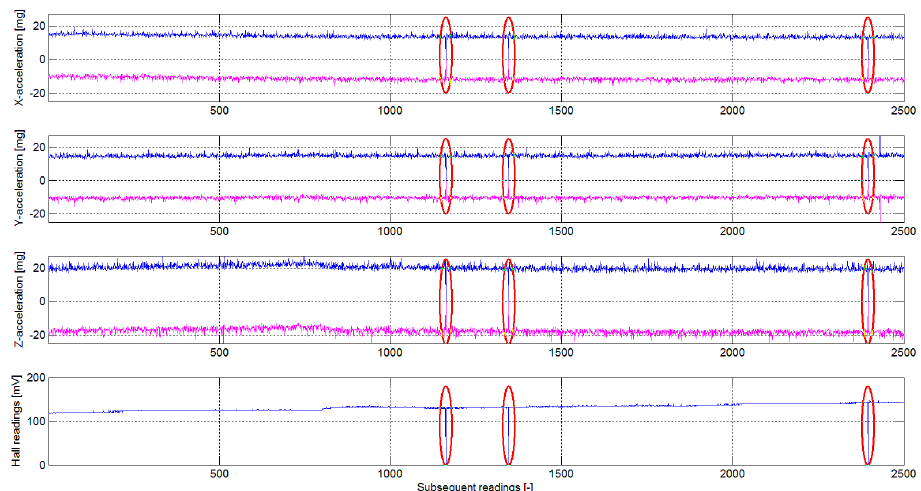
Figure 16. Raw data registered by node 1 with errors marked.